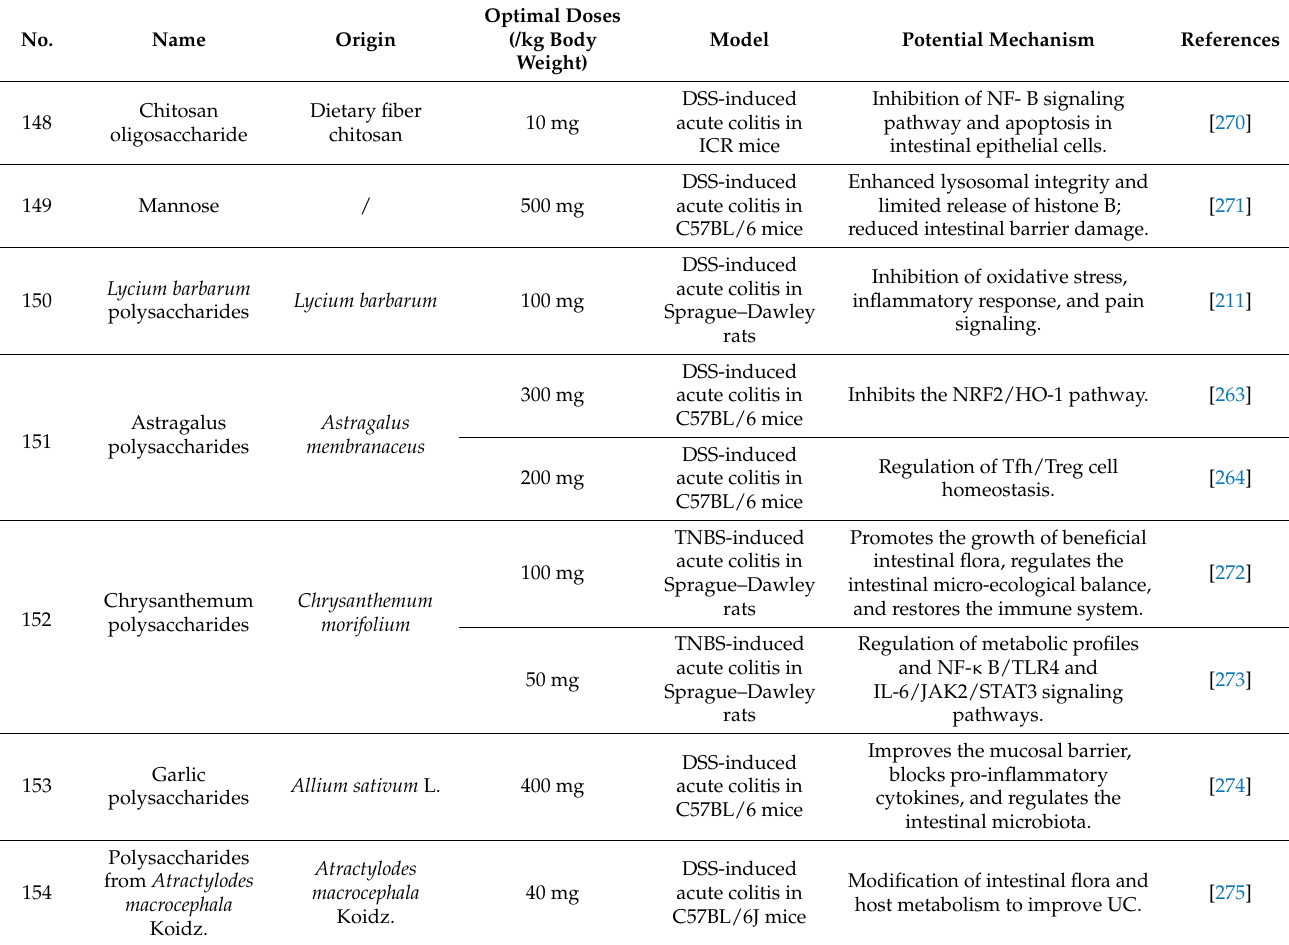
Table 8. In vivo therapeutic effects of natural polysaccharides on experimental